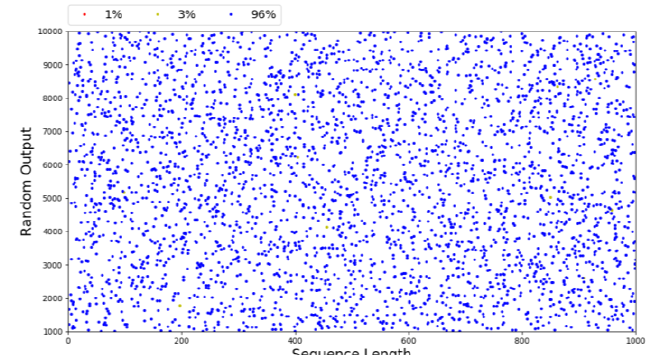
Fig. 21. Random number generation output frequency scatter plot with with-seed post-optimisation low noise scenario